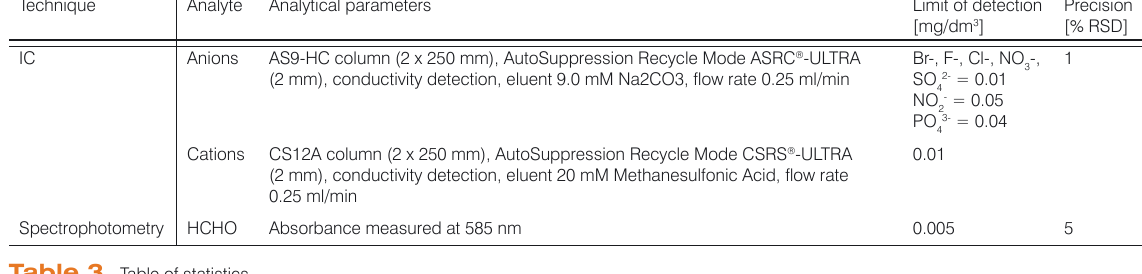
Table 3. Table of statistics.